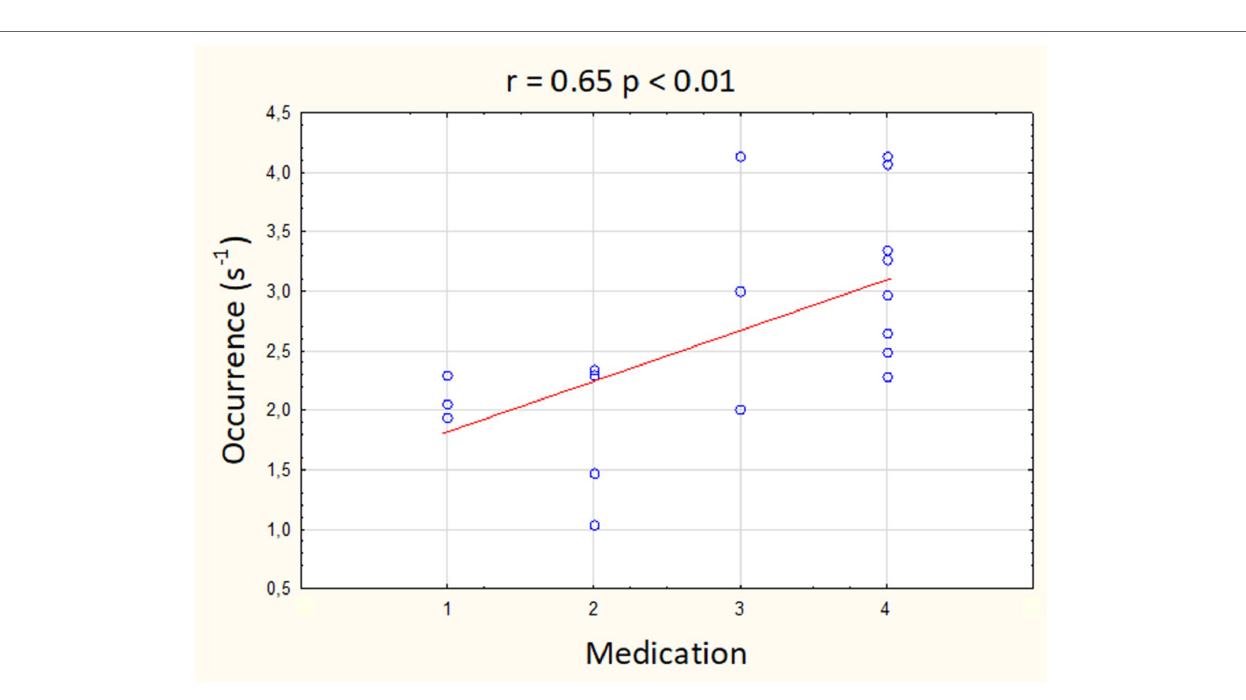
FIGURE 4 | Correlation between the occurrence of microstate E and the intake of antidepressants, antipsychotics, and mood stabilizers. Medication scale: 1, one medication in sub-therapeutic doses; 2, one medication in therapeutic doses; 3, combination of medications with one in therapeutic doses; 4, combination of medications with more than one in therapeutic